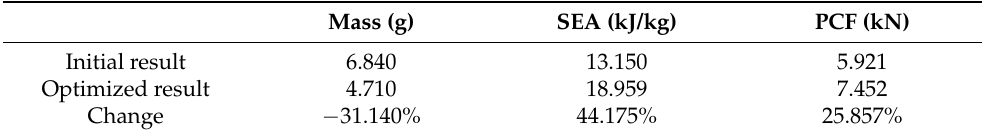
Figure 23. Comparison of stress–strain between optimized and original results. Table 11. Comparison of optimized and original